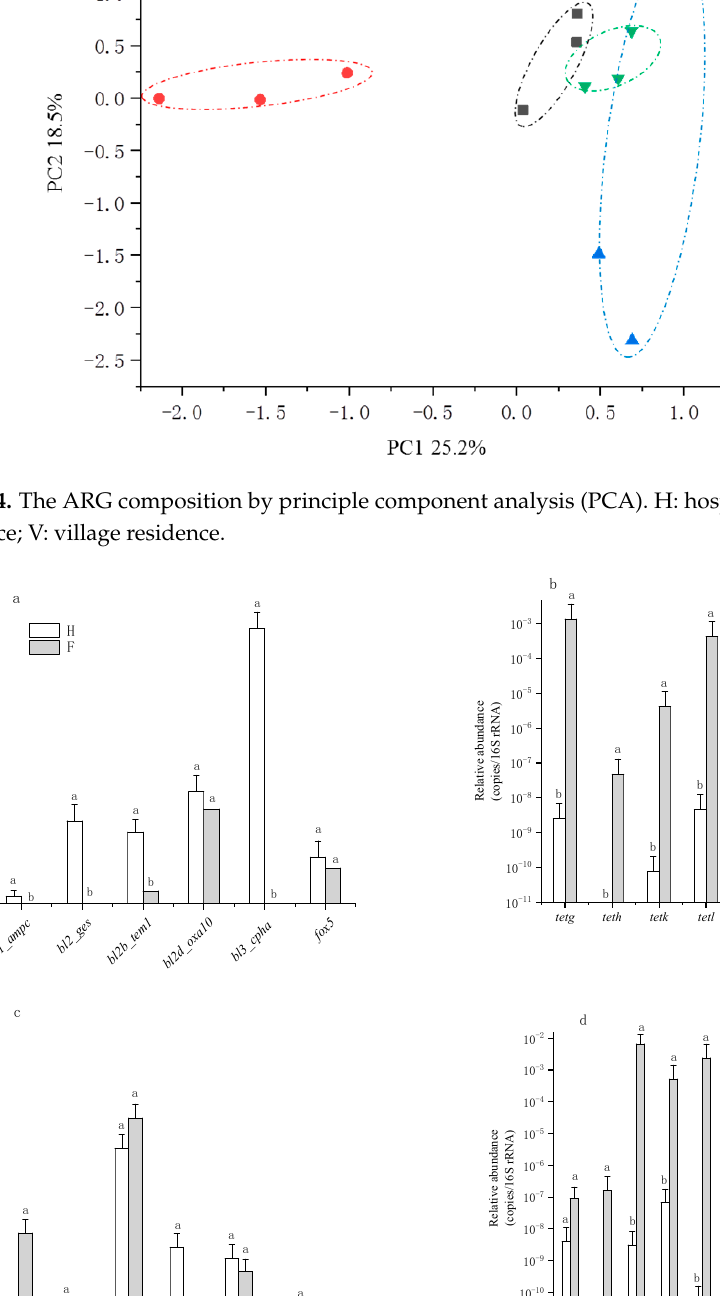
Figure 5. The relative abundance of ( a ) beta-lactam resistance genes, ( b ) tetracycline resistance genes, ( c ) multidrug resistance genes, and ( d ) MLSB resistance genes. H: hospital; F: farm. MLSB: macrolide–lincosamide–streptogramin B resistance. Error bars indicate standard errors of three replicates, different lowercase letters indicate a significant difference ( p < 0.05).